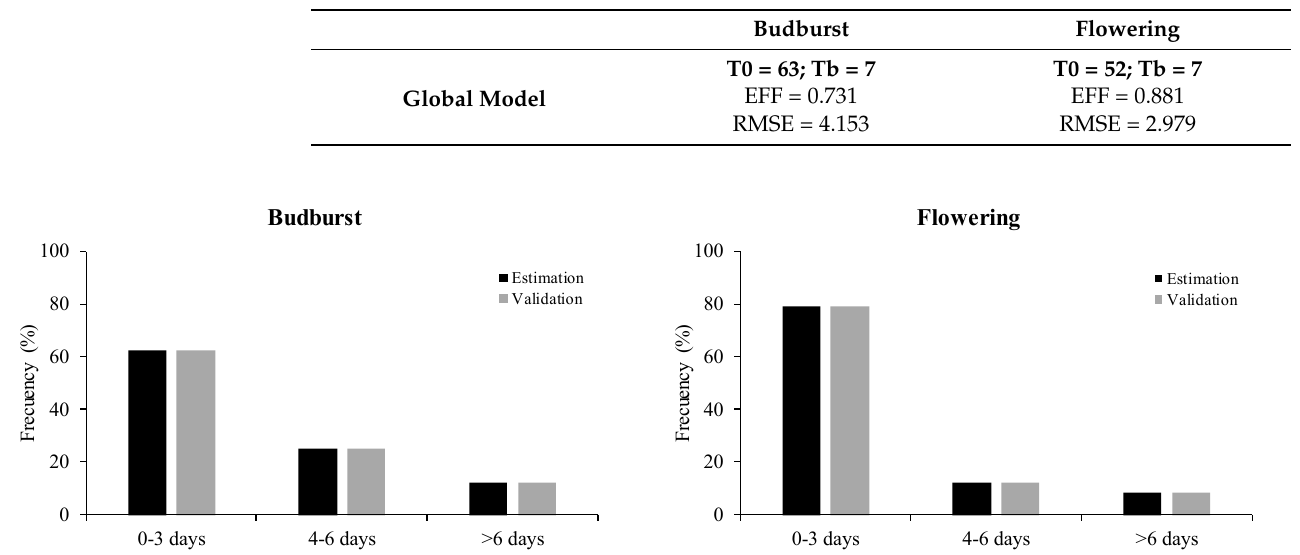
Figure 4. Frequency in the percentage of difference in days between predicted and observed budburst and flowering dates for the GDD Global model (estimation and validation values).